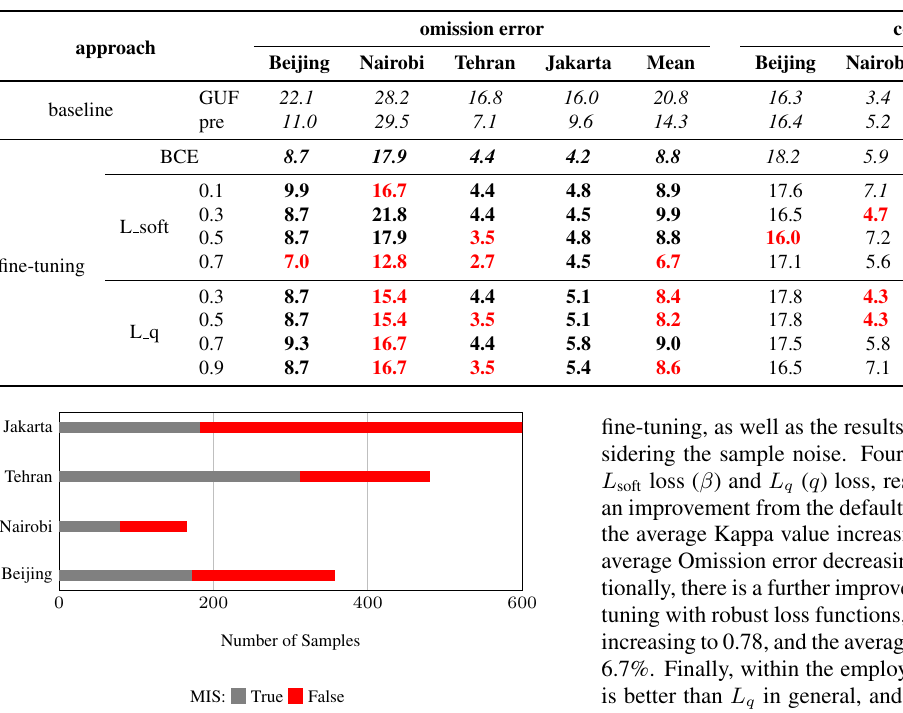
Table 2. Omission and commission error percentages for different approaches in the four test cities. Boldface indicates there is an improvement over results from pre-trained classifiers (Pre), and red color indicates an improvement over the default fine-tuning approach (BCE).